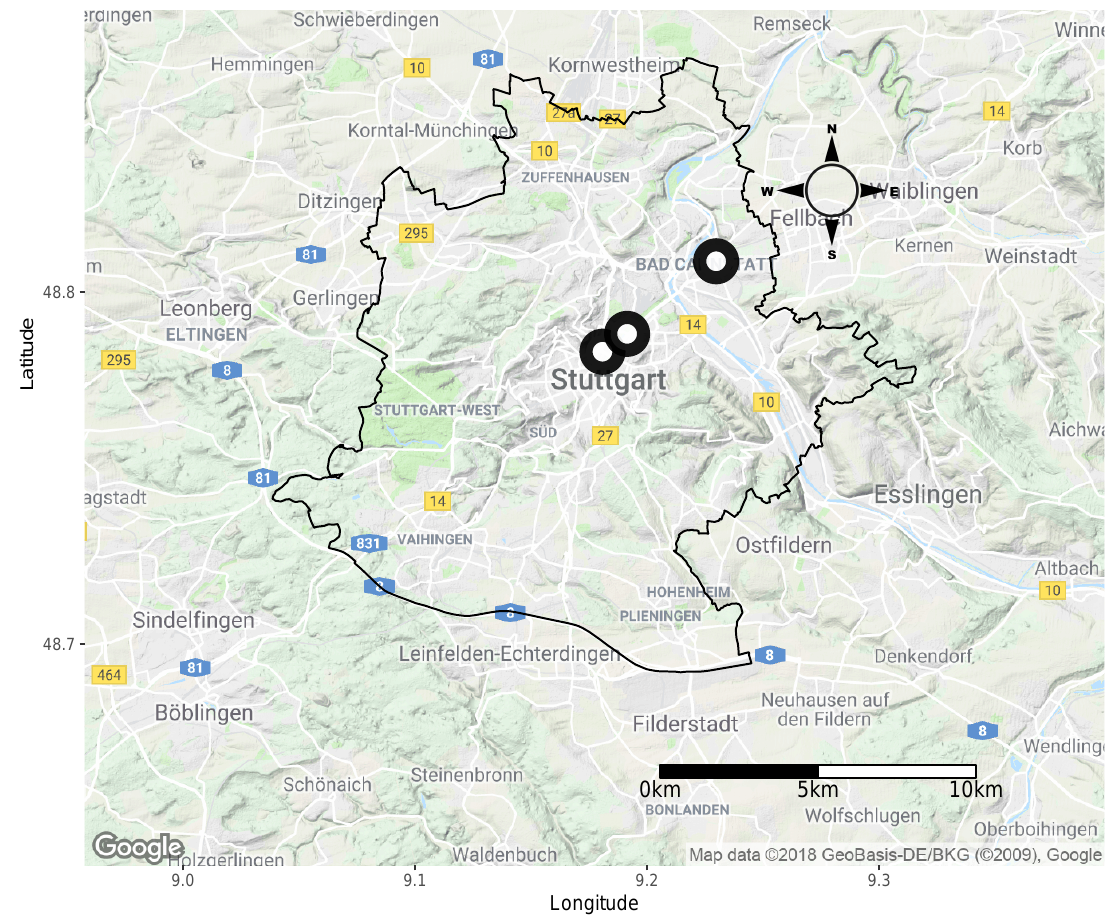
Figure 1. Three official monitoring stations in the city of Stuttgart (Source: Umwelt